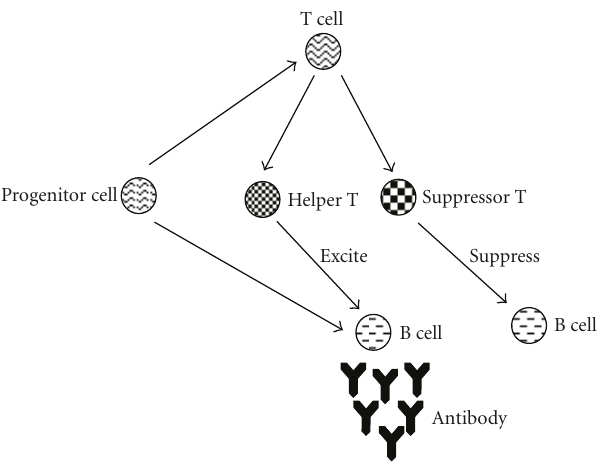
Figure 2: Relation of immune cell.